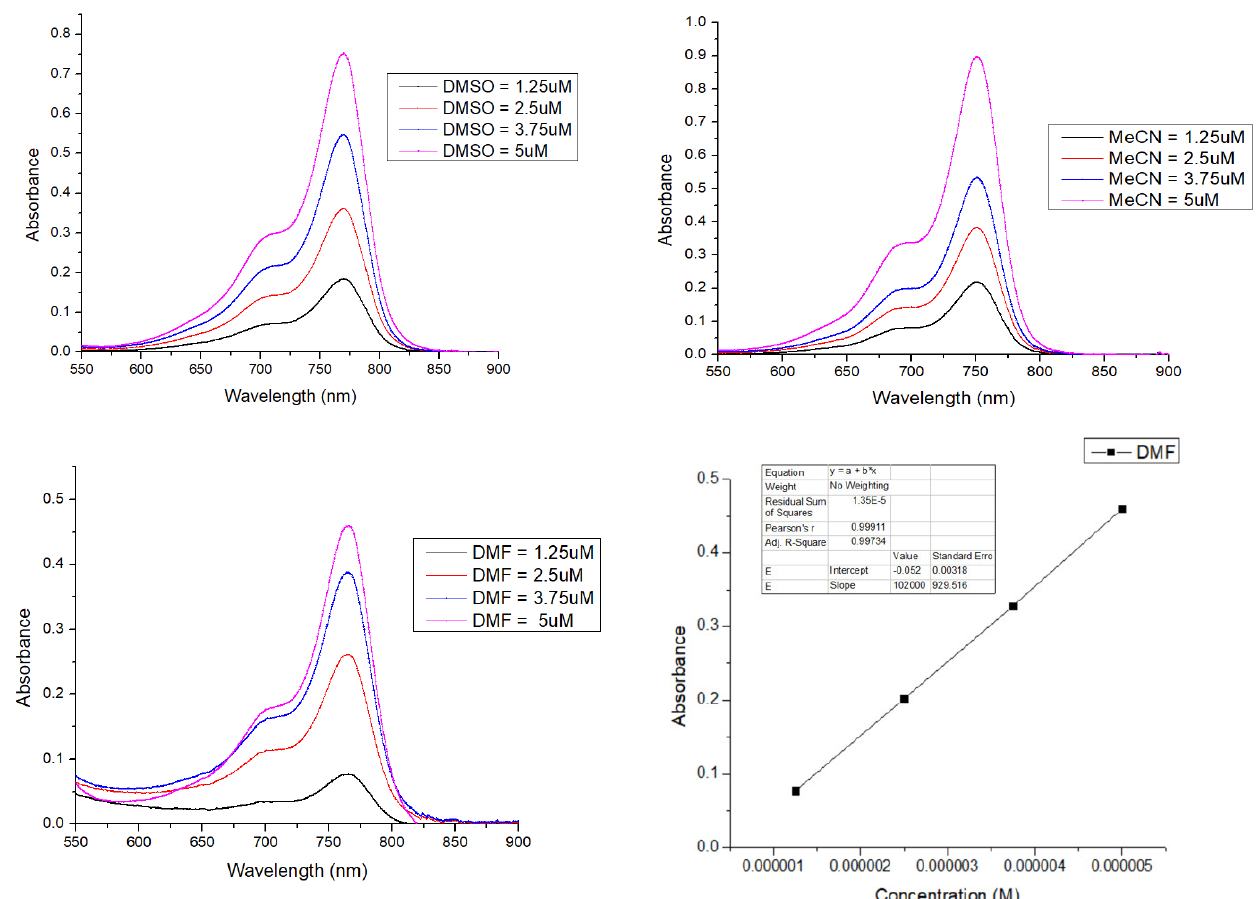
Figure 2. Absorbance profiles of ERB-60 in polar aprotic solvents at different concentrations (1.25 μM, 2.5 μM, 3.75 μM, 5.0 μM). The absorbance increase was linear with respect to concentration and follows the Beer–Lambert law with the extinction coefficient being calculated from the linear regression as ε = 102,000, 151,360 and, 179,920 M −1 cm −1 in N,N- dime- thylformamide, dimethyl sulfoxides, and acetonitrile respectively.